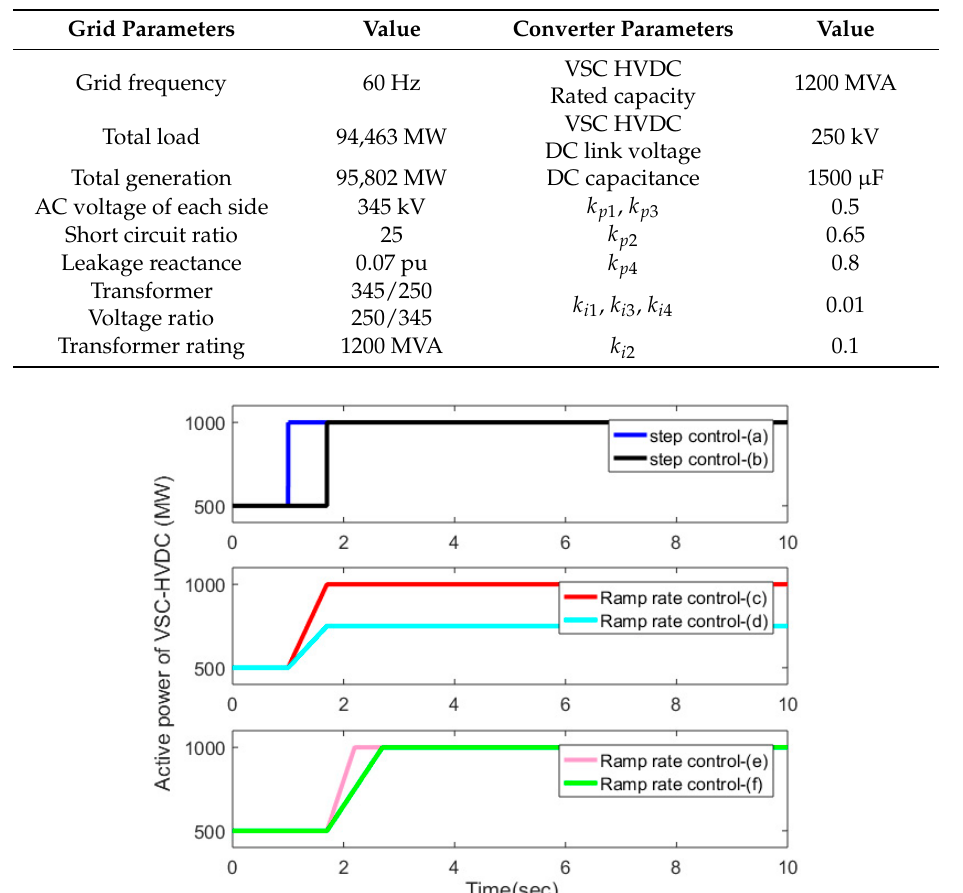
Table 2. System parameters.